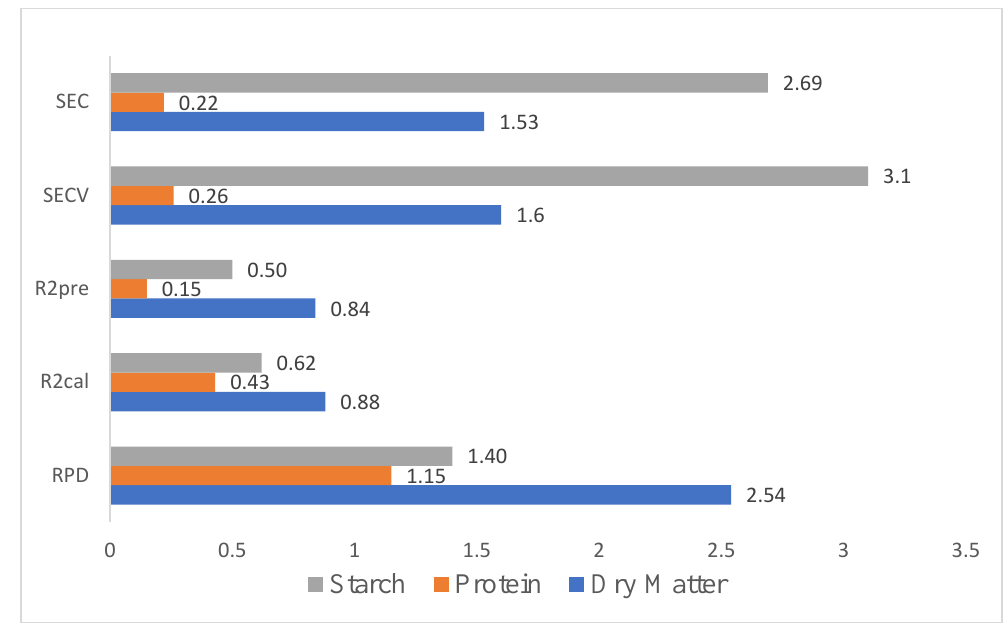
Figure 4. NIRS calibration and validation statistics for grated fresh yam tubers. SEC : standard error of calibration; RPD : the ratio of performance to deviation; SECV : standard error in cross-validation; R 2Cal : the determination coefficient for calibration; R 2pre : the determination coefficient for prediction.